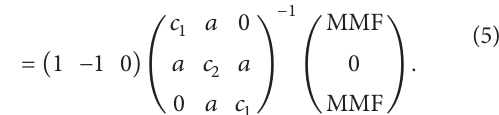
represented by both color table and contour lines, in single GMM case is detailed in Figure